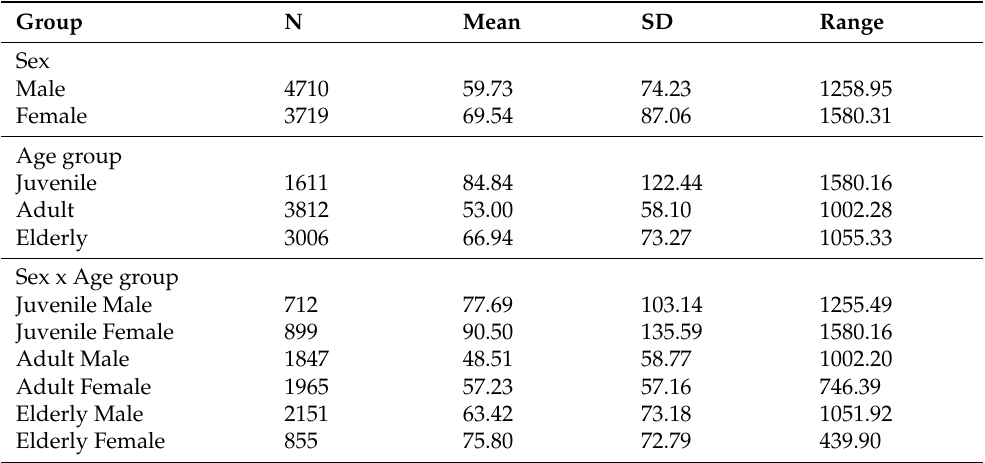
Table 1. Descriptive statistics for FCM concentrations (ng/g dry feces) for the different fixed effects and interactions included in the statistical model. Means and standard deviations (SD) presented are from the raw data before analysis.